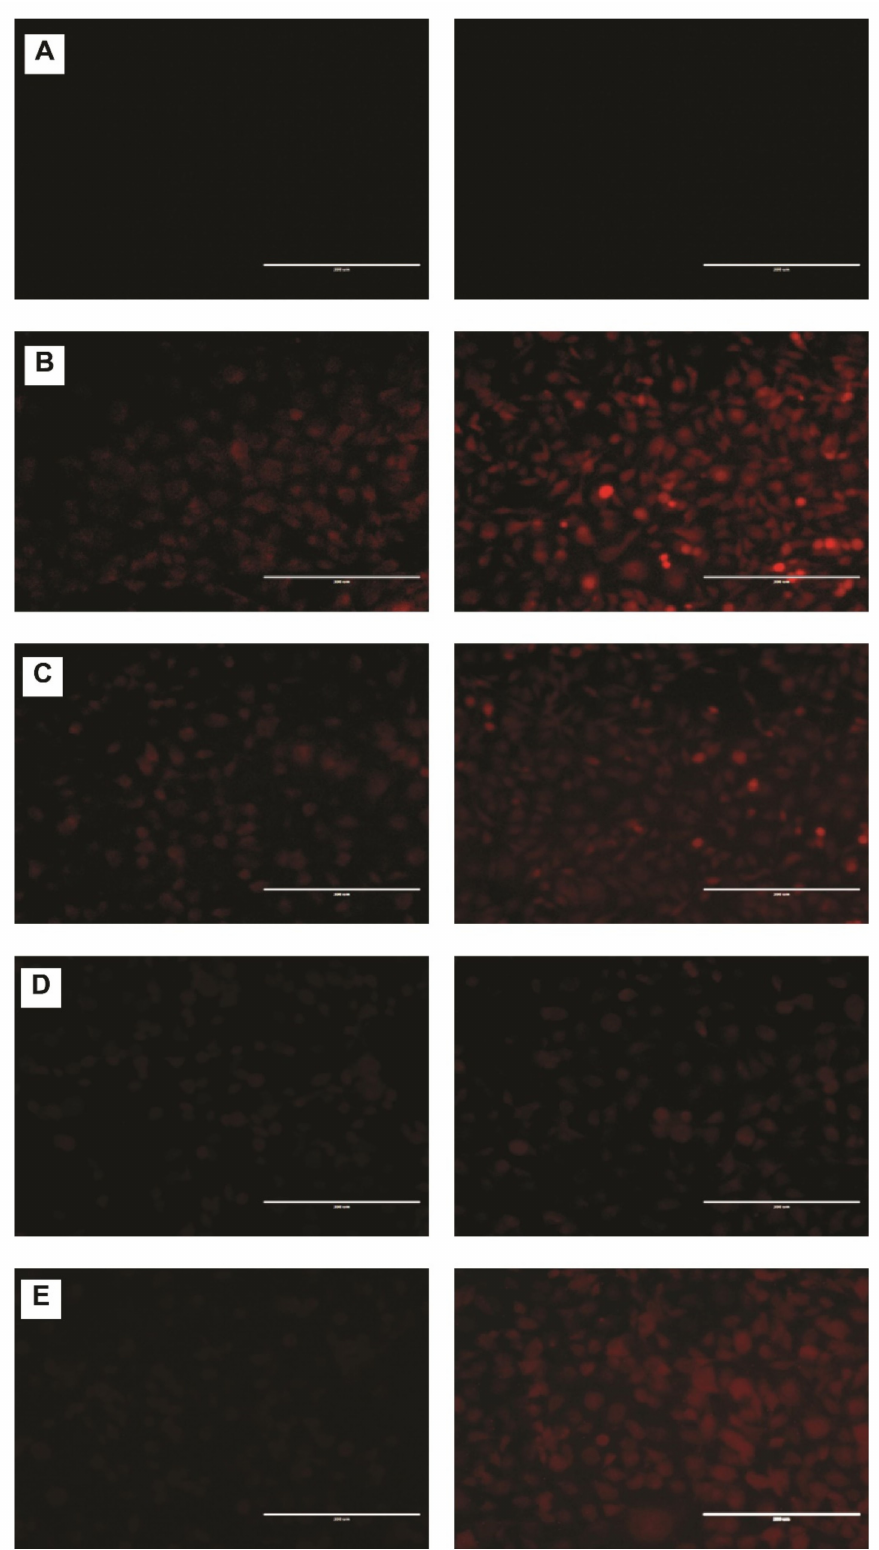
Figure 6. Fluorescence microscopy showing CL enhanced DNR uptake from TSL after exposure to mild hyperthermia (42 ◦ C, 10 min) after 0.5 h (left) and 6 h (right). MDA-MB-231 cells were cultured for 24 h ( A ) and then were treated with F1 ( B ), F2 ( C ), free DNR ( D ) or F3 ( E ). Final liposomal DNR concentrations were 14 µ M. Scale bar = 200 µ m. Where there is no drug accumulation, the images appear darker with no cell line impressions. TSLs-CL formulation with red color shows DNR